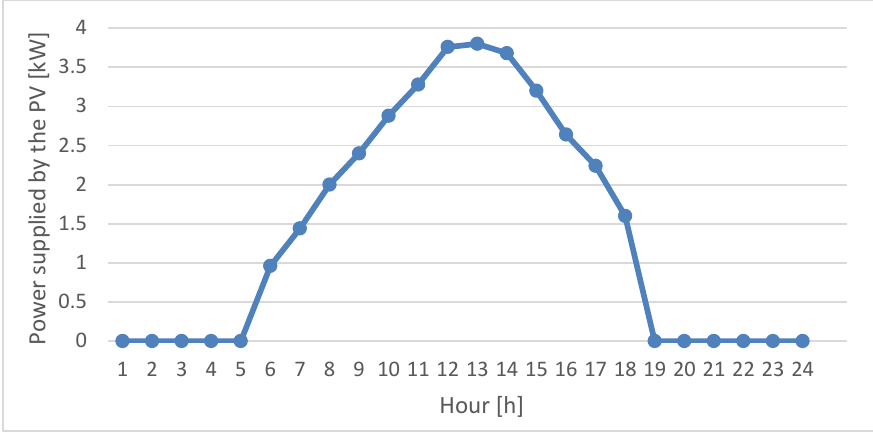
Figure 2. Power supplied by the PV panels.